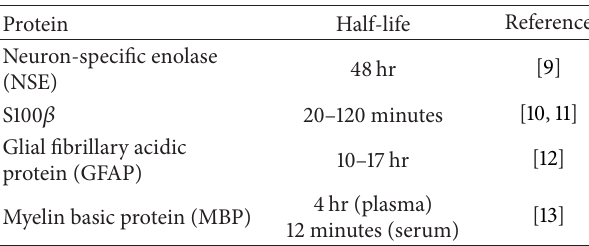
Table 1: Serum/plasma half-life of some proteins proposed as biomarkers of